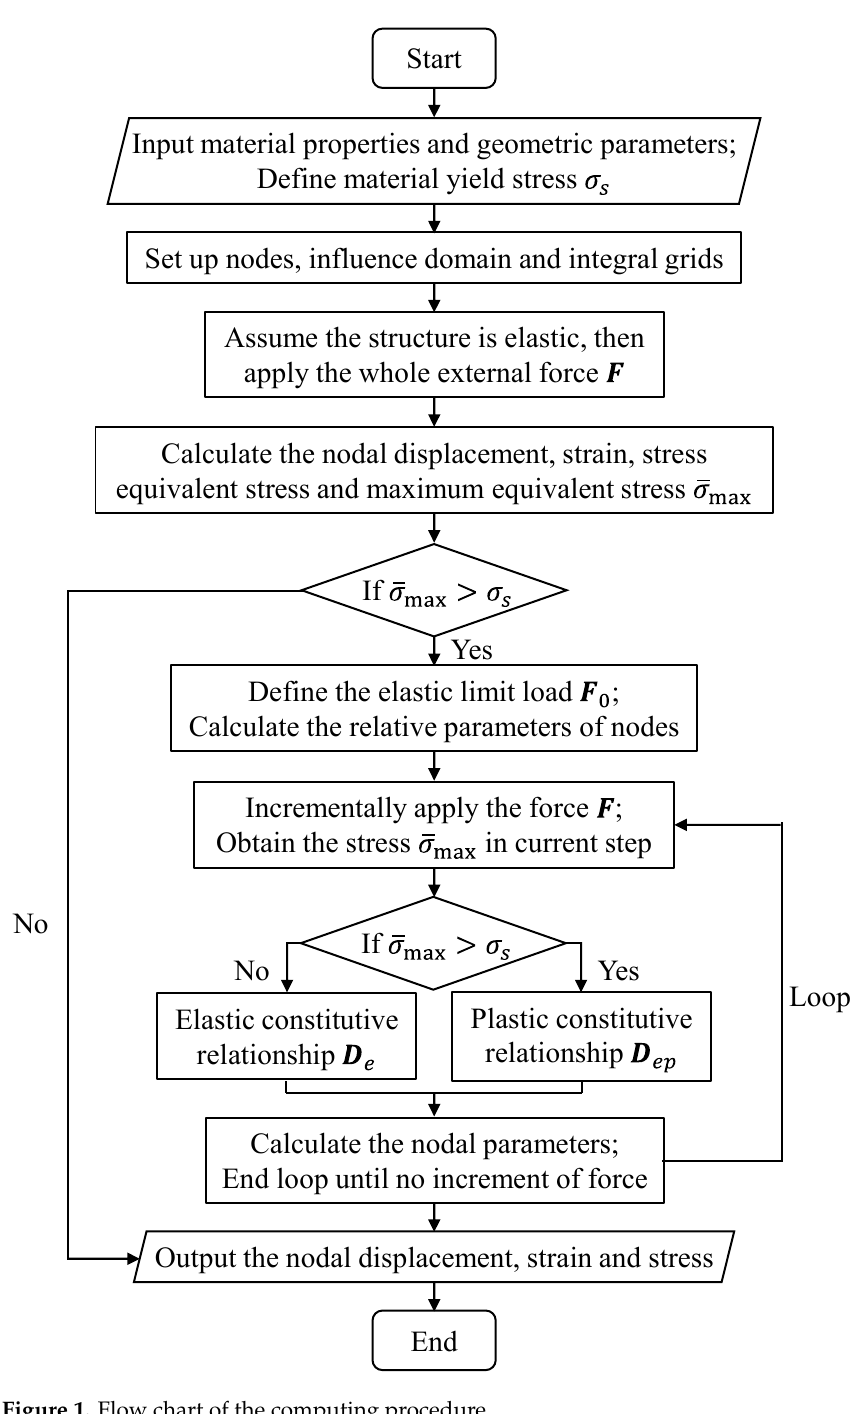
Figure 1. Flow chart of the computing procedure.